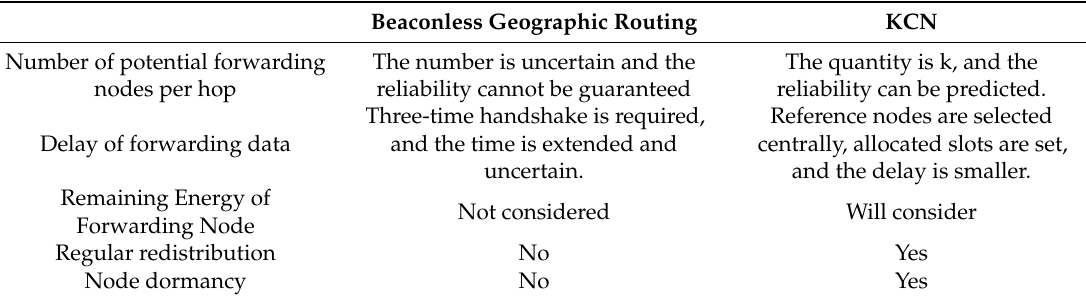
Table 1. Comparison of KCN and beacon-free routing.